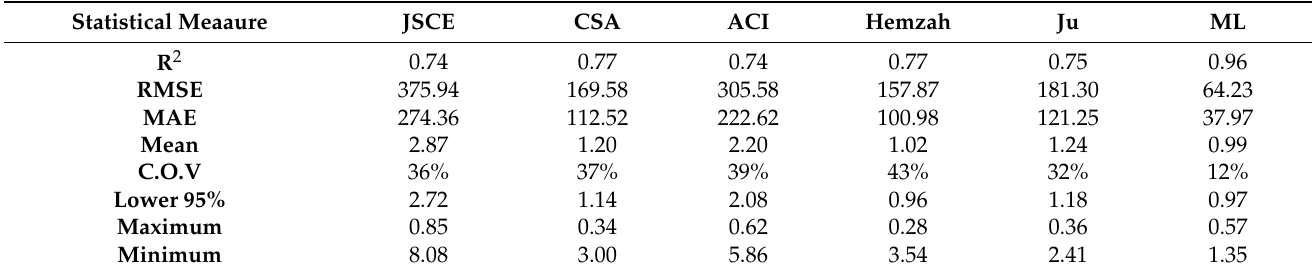
Table 4. Statistical measures for the SF calculated using the existing models and the ML